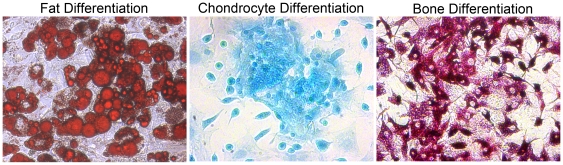
MSCs were functionally verified.Functional assays verified tri-lineage differentiation potential of mesenchymal stem cells after culturing for three weeks. Adipogenic differentiation was verified by staining with Oil Red-O; lipid droplets stained a red color. Chondrogenic differentiation was verified by staining with alcian blue; matrix sulfated proteoglycans stained a turquoise blue color. Osteogenic differentiation was verified by alkaline phosphatase staining; osteogenic cells stained a deep fuschia color.